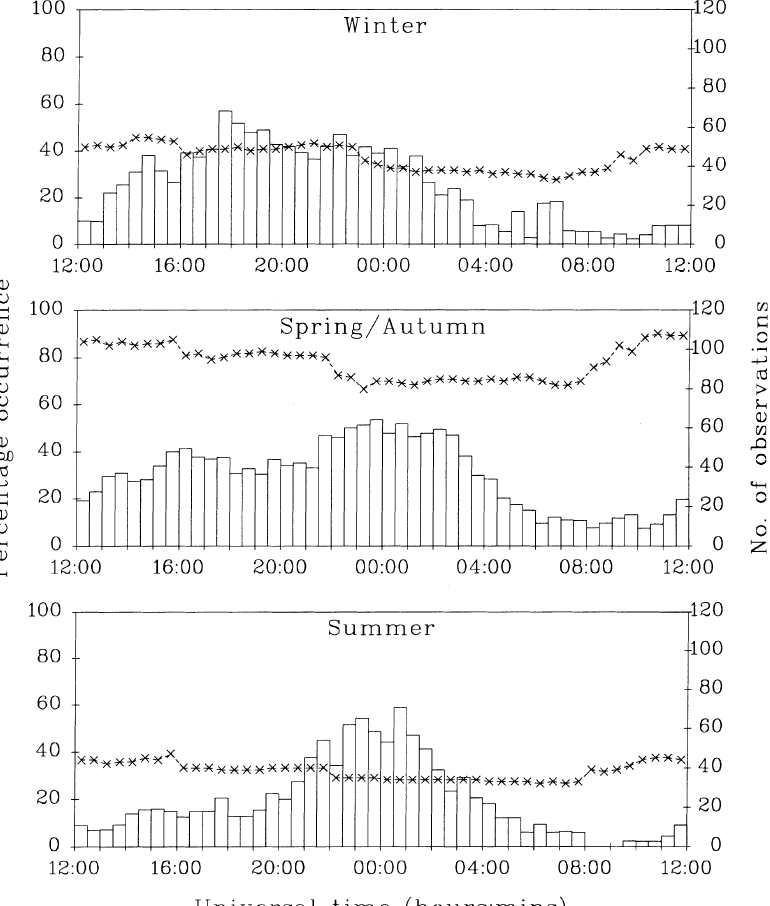
Fig. 5. Seasonal variation of the diurnal distri- bution of ion frictional heating at 312 km. The format of each panel is as for